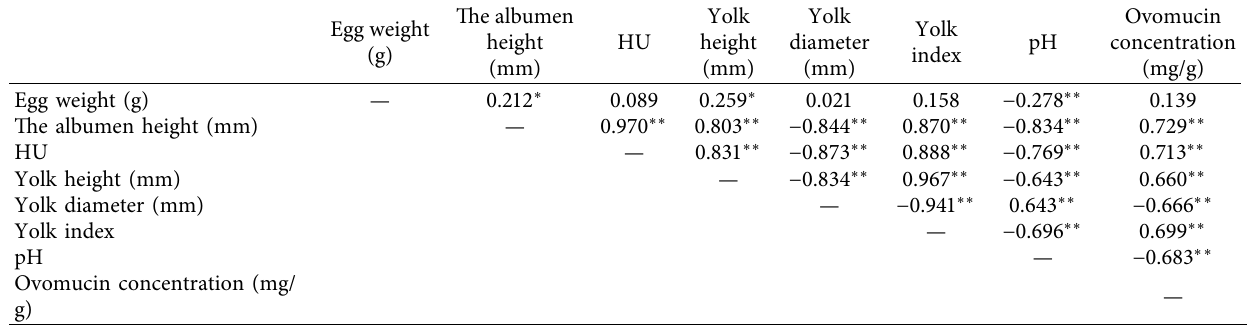
Table 2: Results of Pearson correlation analysis between ovomucin concentration and each egg freshness indexes.